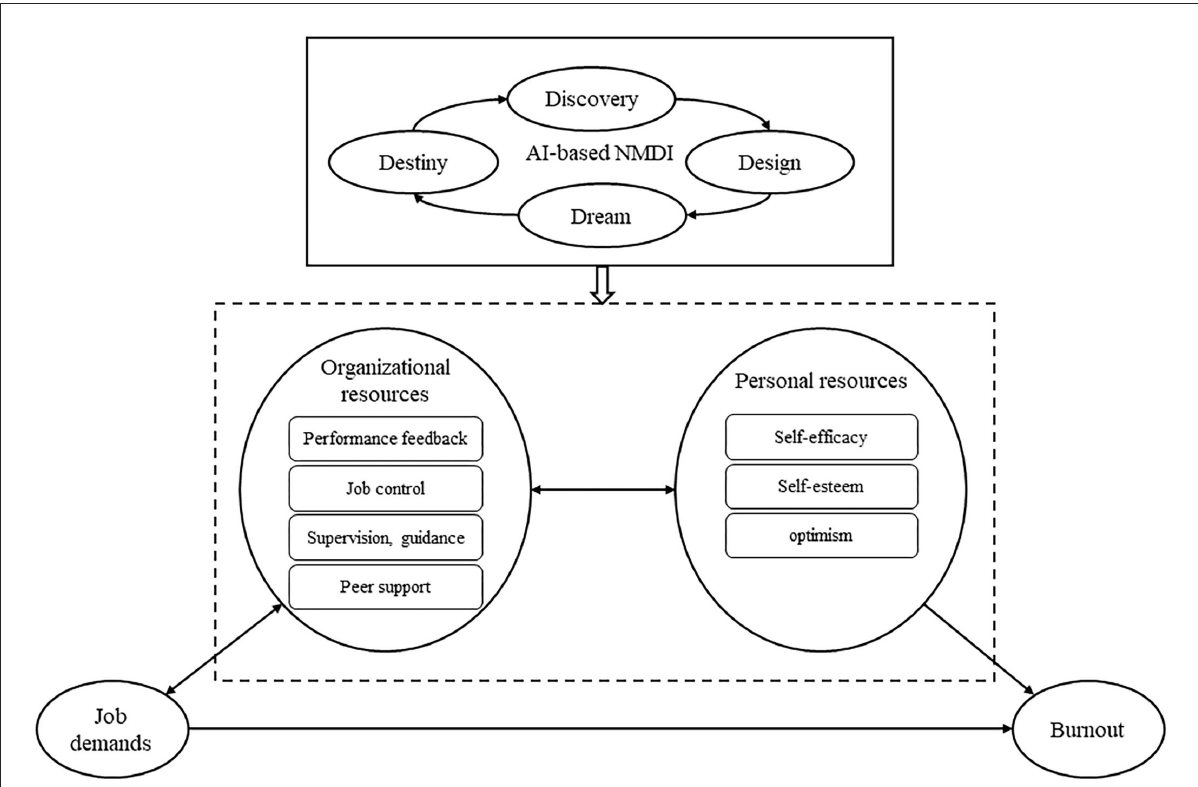
FIGURE1 Theoritical framework for AI-based NMDI program targeting in burnout